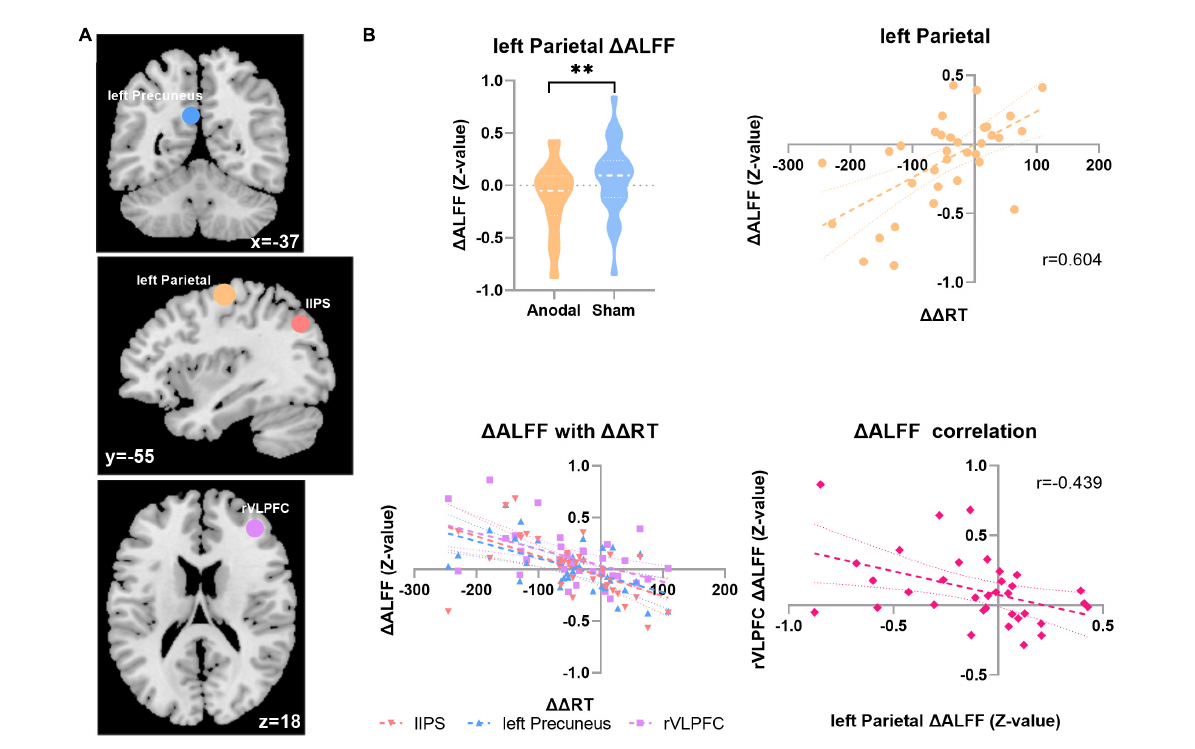
FIGURE3 ALFF with the distractor effect results. (A) The (cid:49) ALFF in four ROI correlated with the (cid:49)(cid:49) RT in two sessions in the anodal stage. Top, coronal; middle, sagittal; and bottom, axial. Blue, left precuneus; yellow, left parietal; tangerine, lIPS; violet, rVLPFC. (B) Top left, the (cid:49) ALFF result in the left parietal region in the two stages; top right, correlation result between (cid:49)(cid:49) RT and (cid:49) ALFF in the left parietal region in the anodal stage; bottom left, (cid:49)(cid:49) RT correlation result with the (cid:49) ALFF in the three regions; bottom right, (cid:49) ALFF correlation result between the rVLPFC and left parietal region. ∗∗ p <